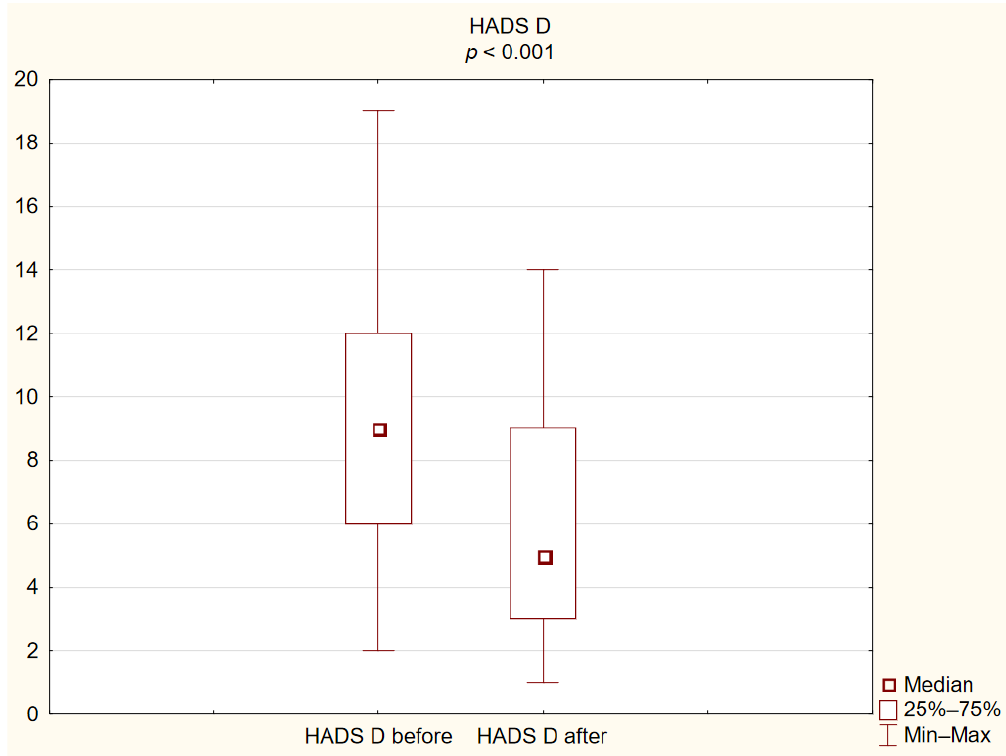
Figure 3. Worsening of depression symptoms before and after the rehabilitation program, Wilcoxon test.